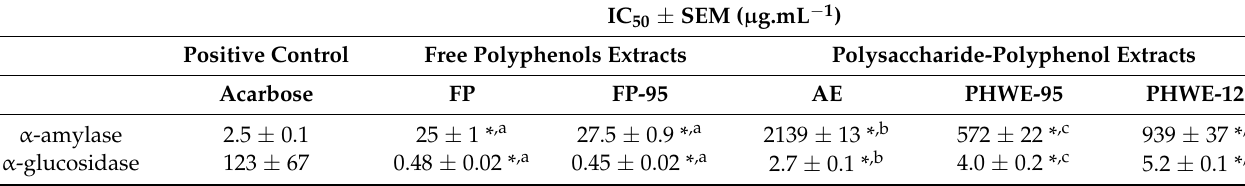
Table 3. IC 50 of α -Amylase and α -glucosidase inhibition by free polyphenols extracts (FP, FP-95) and polysaccharide– polyphenol extracts (AE, PHWE-95, PHWE-120). Results are presented as the mean ± standard error of the mean (SEM) ( n = 9). Values with the symbol (*) are different from the positive control ( p < 0.05). For the same enzyme, columns with different letter are significantly different ( p <